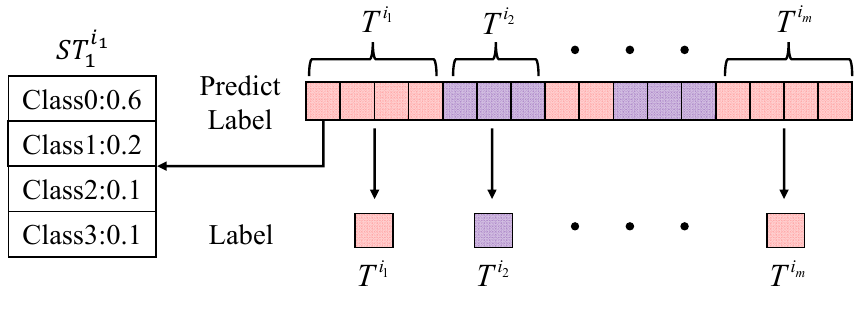
Figure 13. Prediction of Bi-GUR.